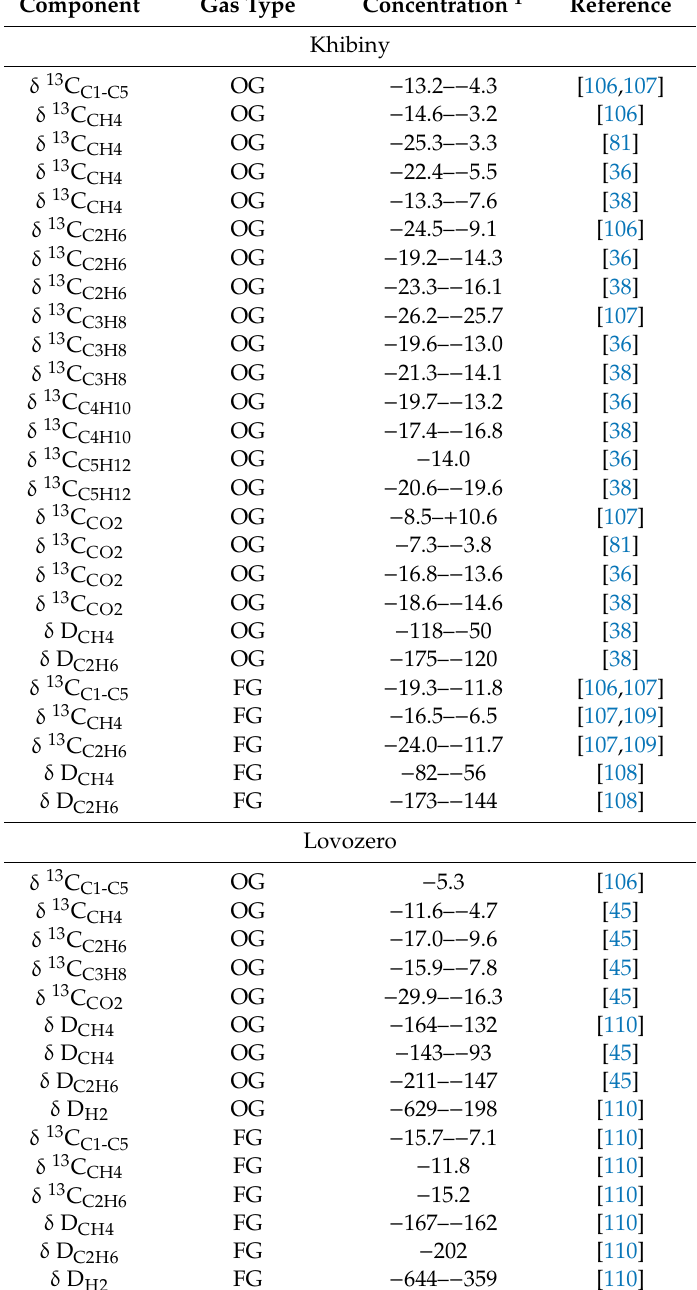
Table 5. Isotope compositions of carbon and hydrogen in the occluded and free gases of the Khibiny and Lovozero